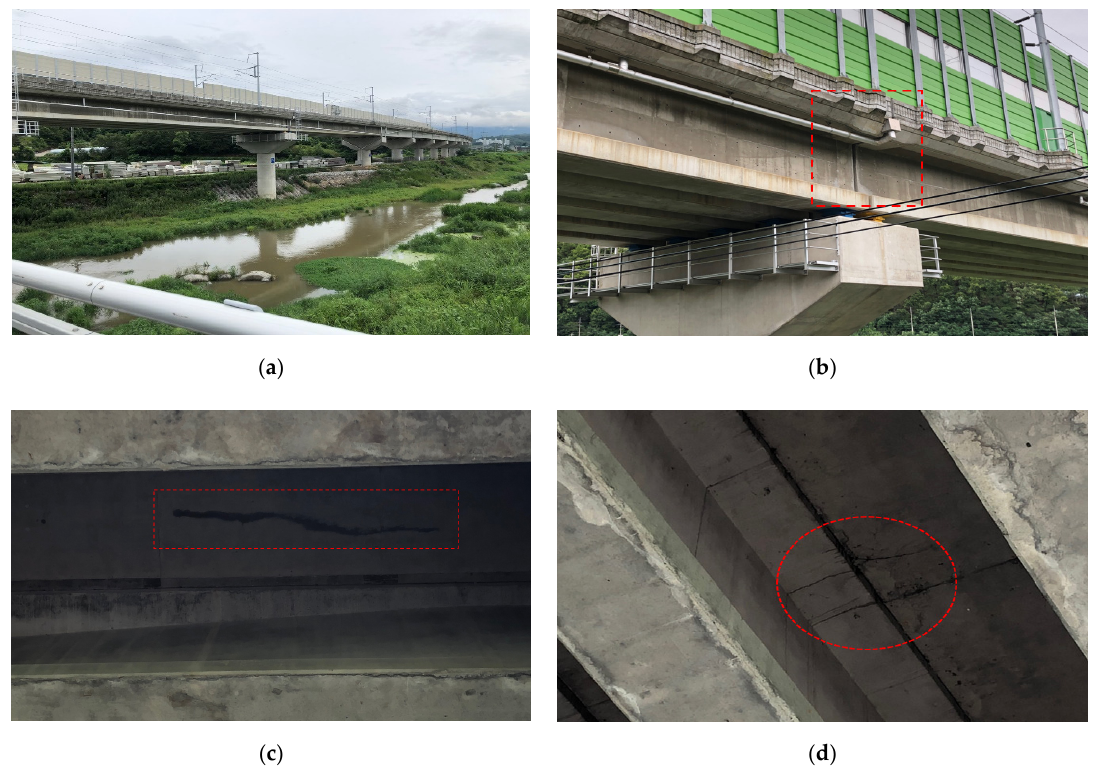
Figure 1. Bridge structure degradation status; ( a ) bridge overview, ( b ) bridge joint section, ( c ) bridge underside leakage crack 1, ( d ) bridge underside leakage crack 2.